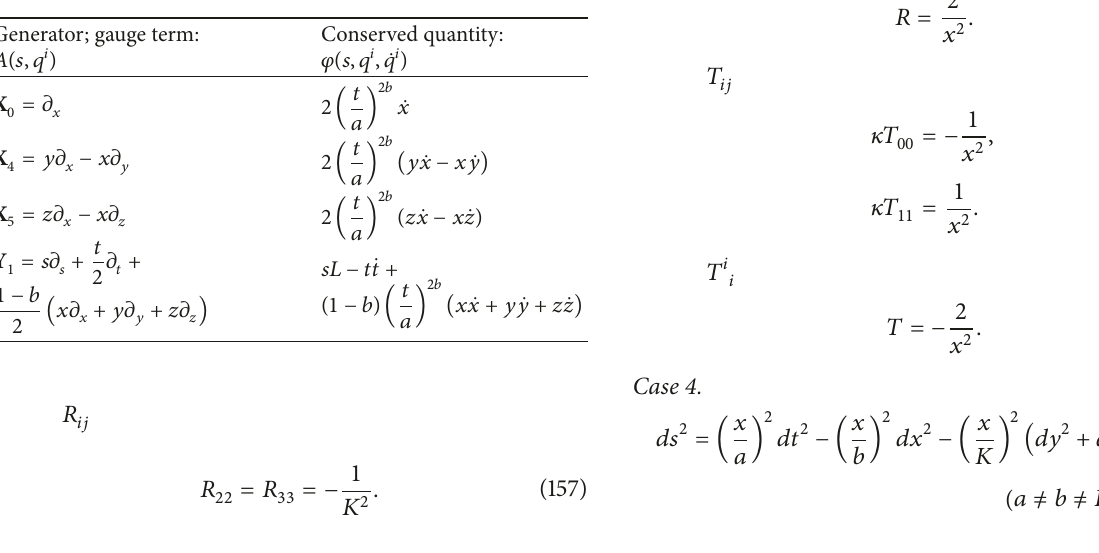
Table 27: Conserved quantities corresponding to each Noether symmetry.